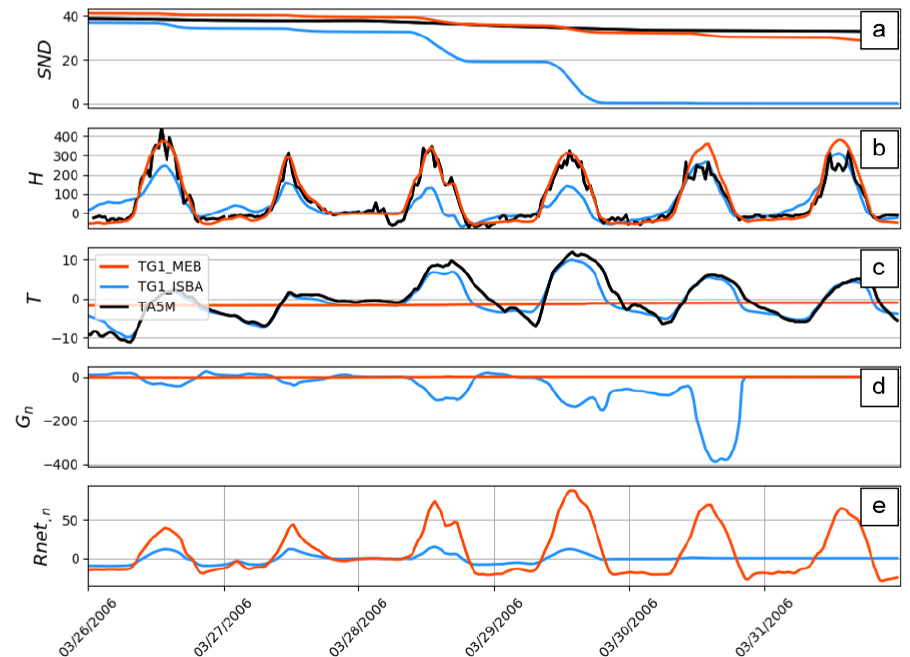
Figure 7. Multiple variables at the OJP site from 25 to 31 March 2004, which corresponds to a melting period of the snowpack. MEB is in red, ISBA is in blue, and observations are in black. T G 1 is the temperature of the first layer of the surface (i.e. the composite for ISBA and the first layer of the ground for